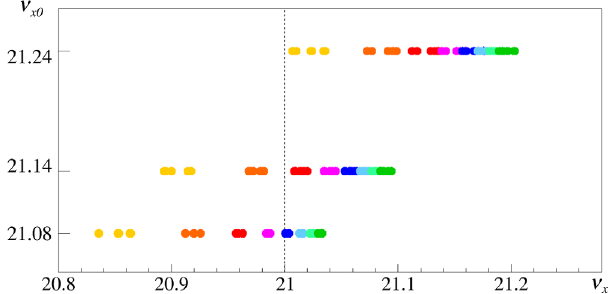
FIG. 10. Incoherent tunes in the NX21 experiment obtained by simulations. The vertical axis represents the bare tune and the horizontal axis represents the incoherent tune. Different actions have been plotted with different colors. The color codes are the same as in Fig.